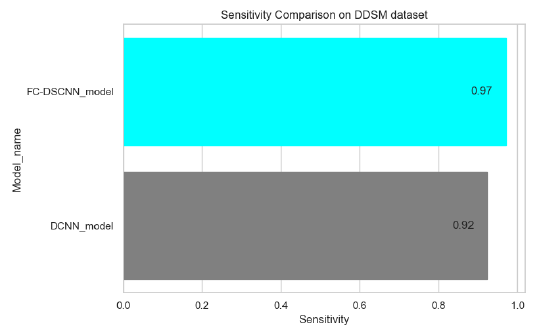
Figure 13. Sensitivity comparison on the DDSM dataset.